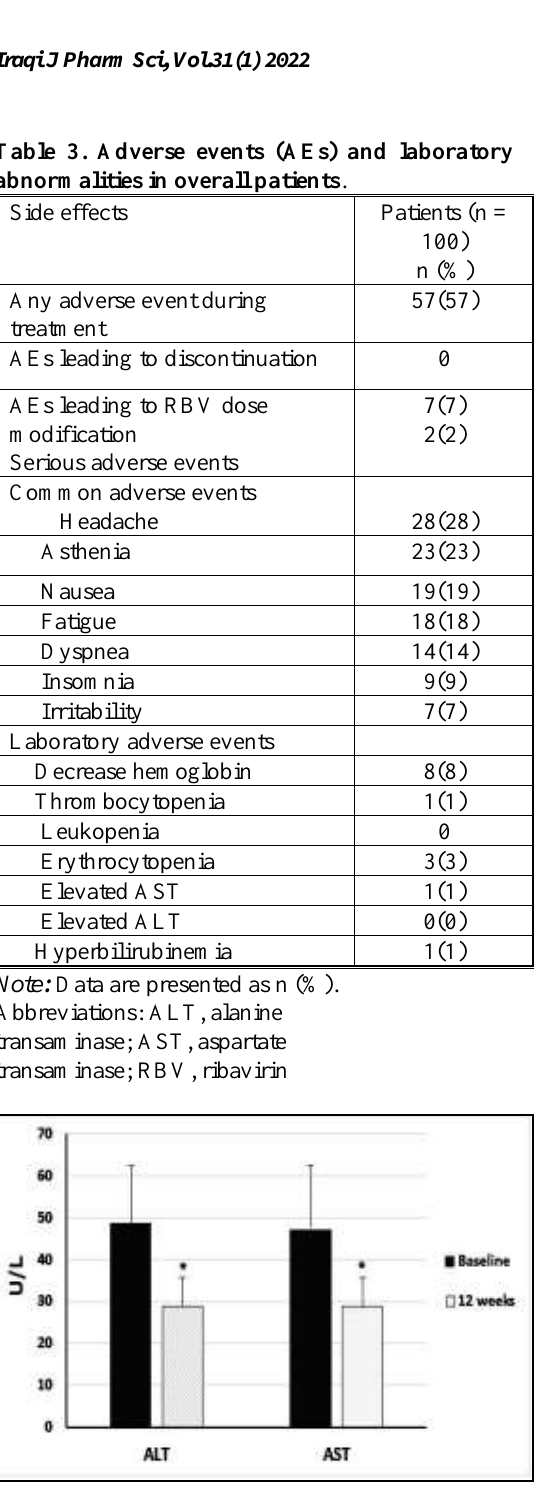
Figure 2. Changes in transaminases at 12 weeks post-treatment among treatment-naive patients treated with OBV/PTV/r plus